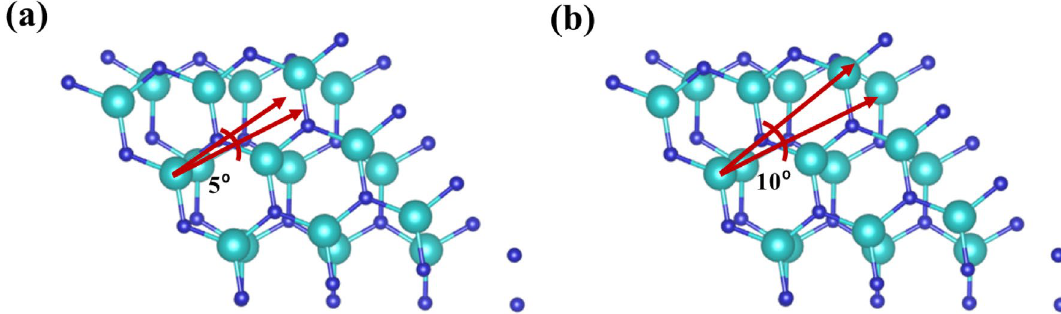
Figure 8. InN bilayer with upper layer is twisted at an angle of ( a ) 5° and ( b ) 10°. Here, the gray and cyan colors refer to N and In atoms,